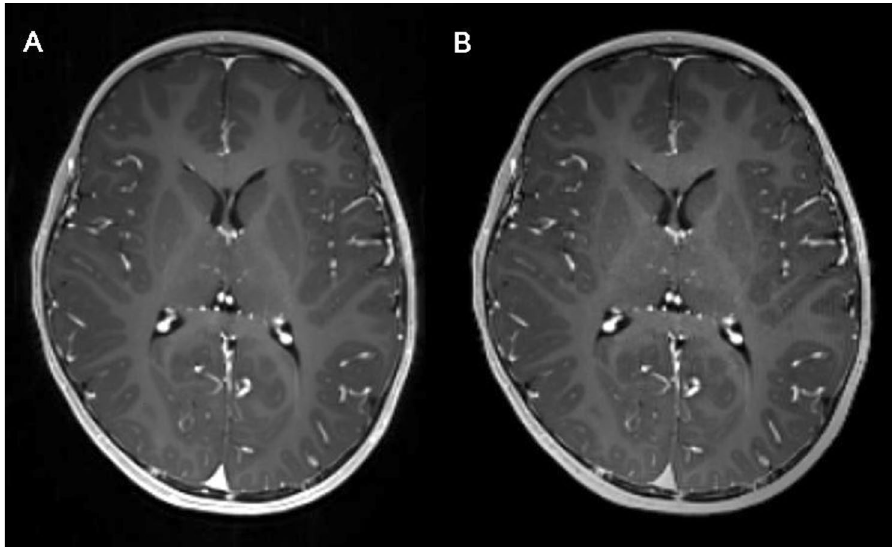
Figure 1. Conventional and wave-CAIPI MPRAGE. Representative image of conventional MPRAGE (A) and wave-CAIPI MPRAGE (B) of a boy aged 3 years and 7 months with